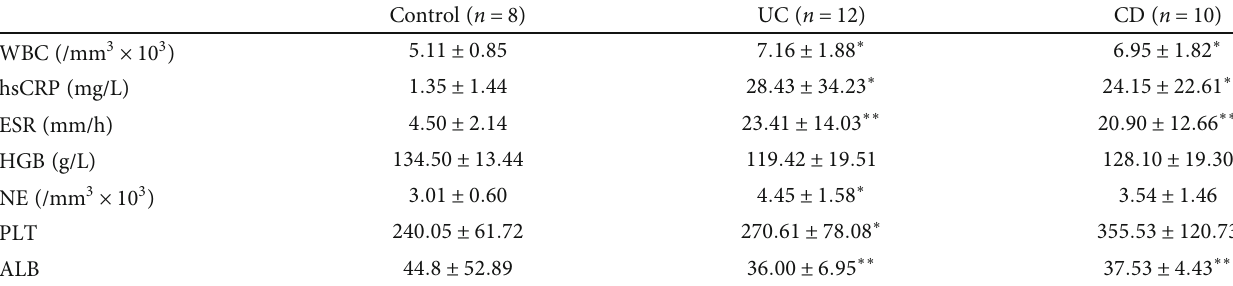
Table 2: In fl ammation markers in IBD patients and